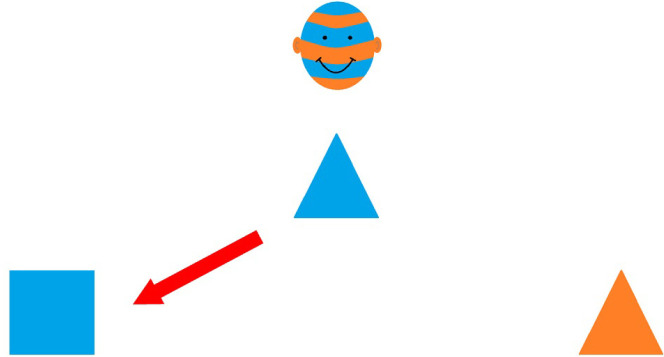
Example a color trial (the arrow only appeared during the instructions).